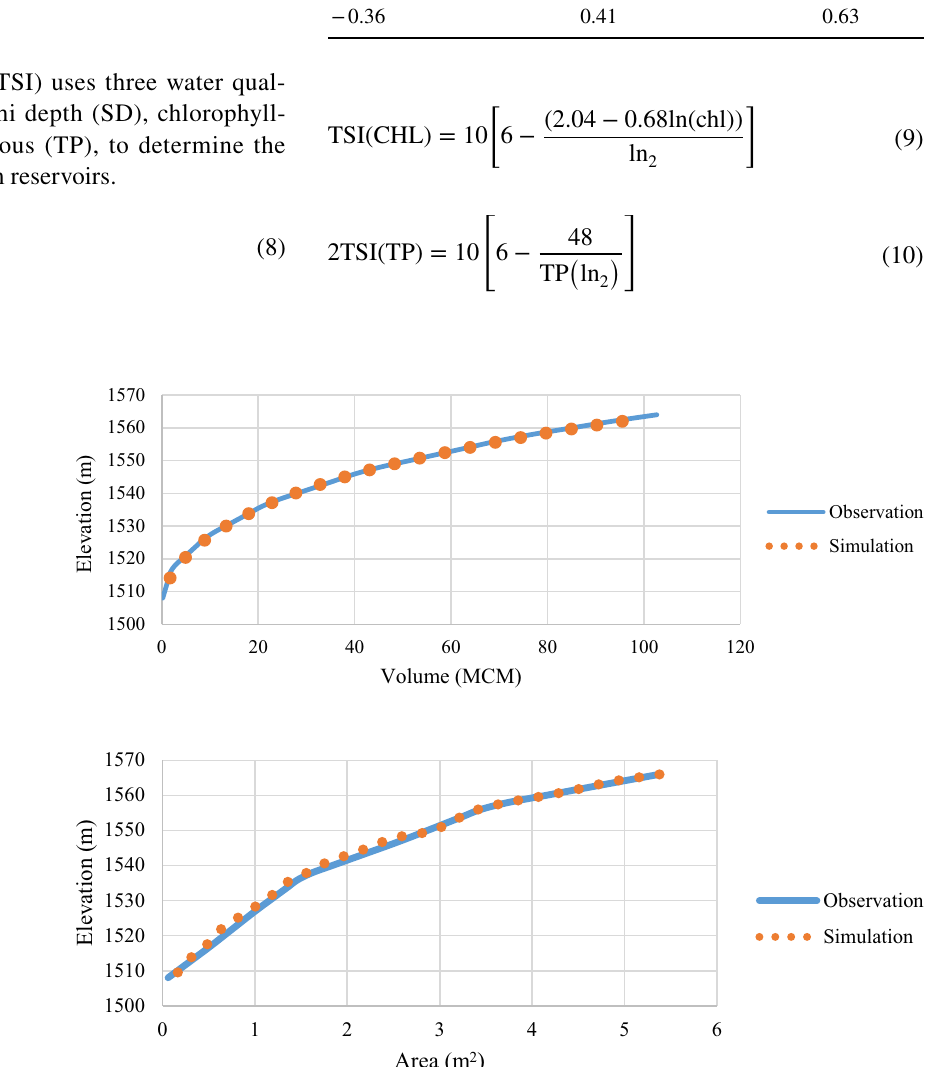
Fig. 6 The observed and simu- lated elevation versus area of the Yamchi dam reservoir